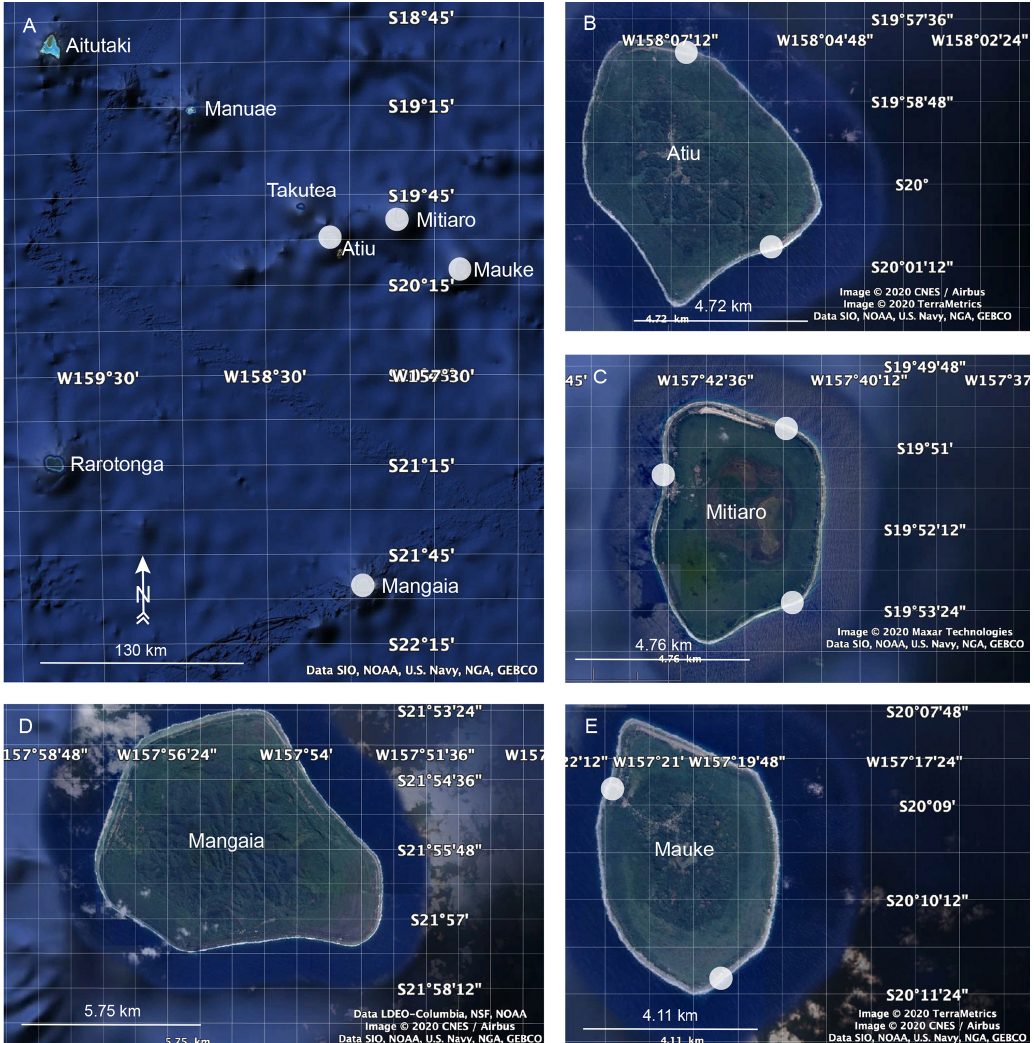
Figure 4. Map showing islands in the southern Cook Islands considered in this article (white circles). Study sites are indicated by white circles. © Google Earth